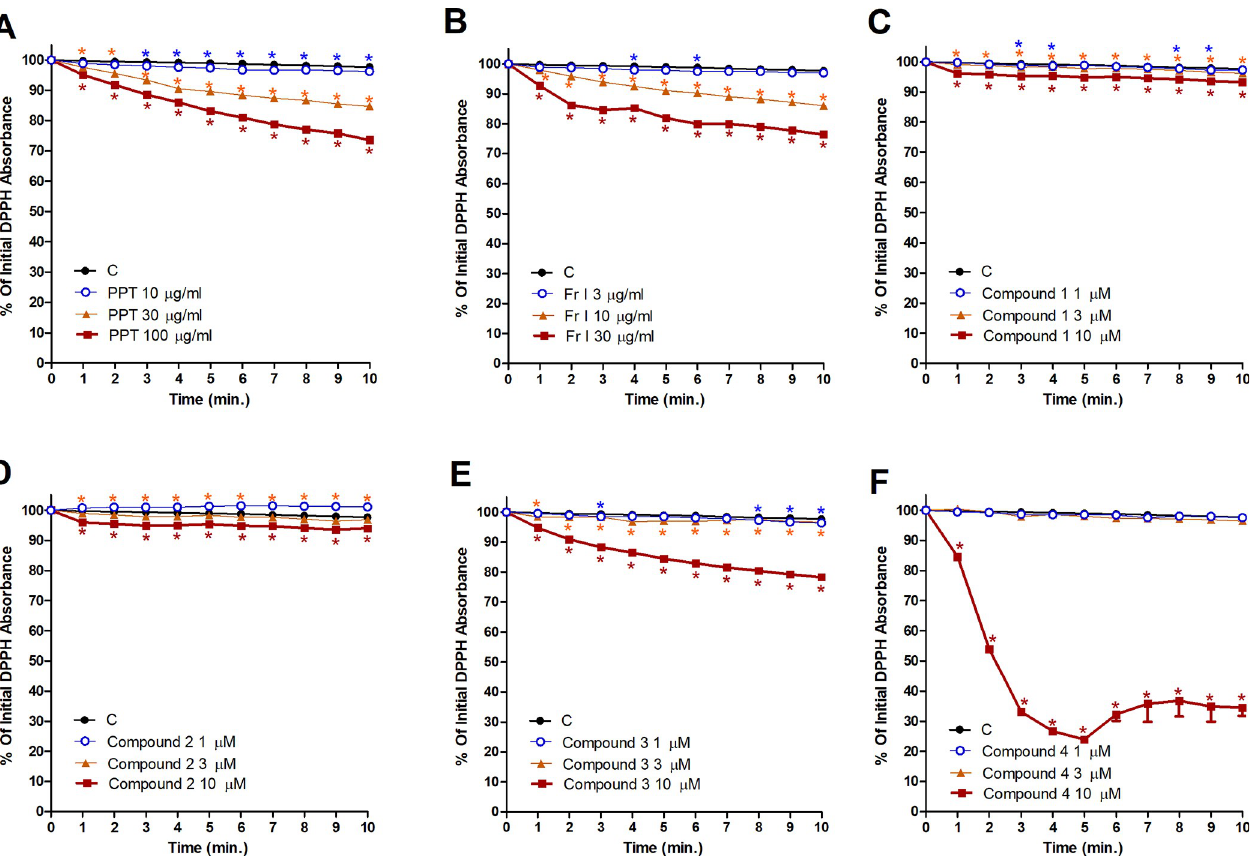
Fig 6. Free radical scavenging activity of different concentrations of PPT (A), Fr. I (B), and isolated compounds 1–4 (C-F) by the DPPH radical assay. DPP radical (violet color) reacts with the extract, bioactive fraction or the isolated compounds to give the reduced form DPPH (pale yellow color) and the intensity of color decreases over time (10 minutes). Data are expressed as percentage decrease of the initial DPPH absorbance. � P < 0.05, compared with the control group; by Tow Way ANOVA and Bonferroni post hoc test.